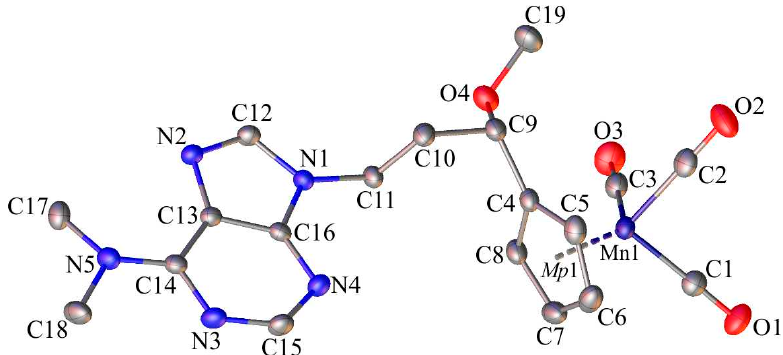
Figure 2. The molecular diagram of 6 with atomic displacement ellipsoids at the 50% probability level; Mp1 corresponds to mid-point of the cyclopentadienyl ring. Hydrogen atoms have been omitted for clarity. Selected bond lengths [Å] and angles [ ◦ ]: Mn1-C1, 1.795(2); Mn1-C2, 1.789(2); Mn1-C3,